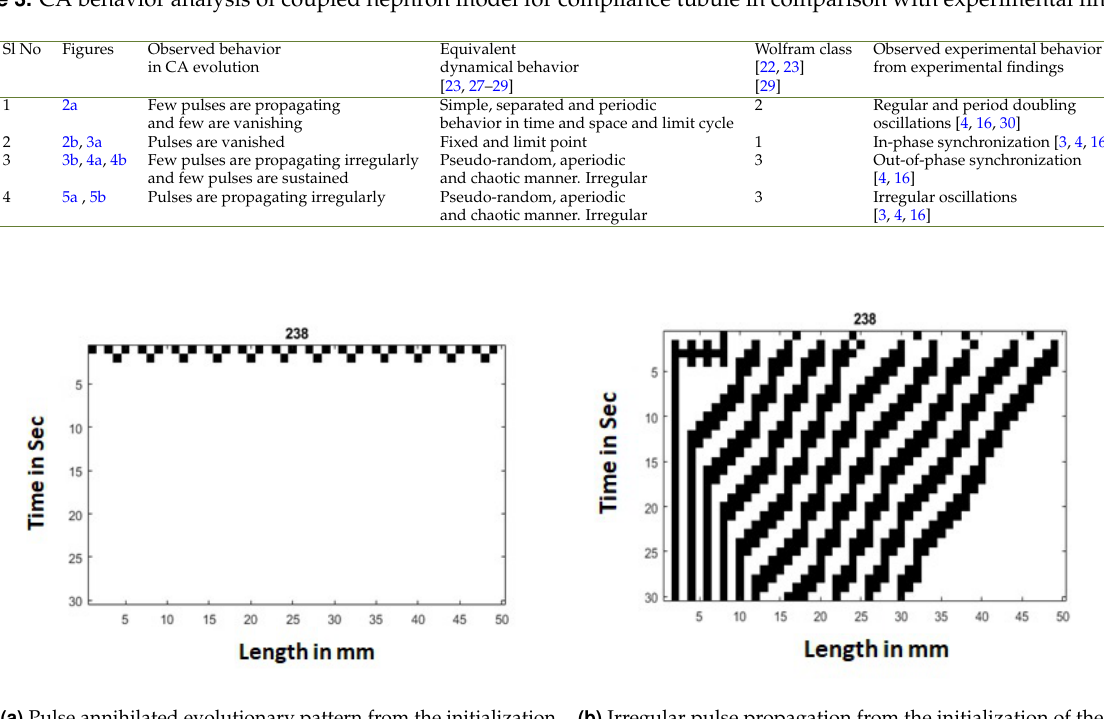
Fig. 3. Evolutionary pattern for pressure in coupled nephron